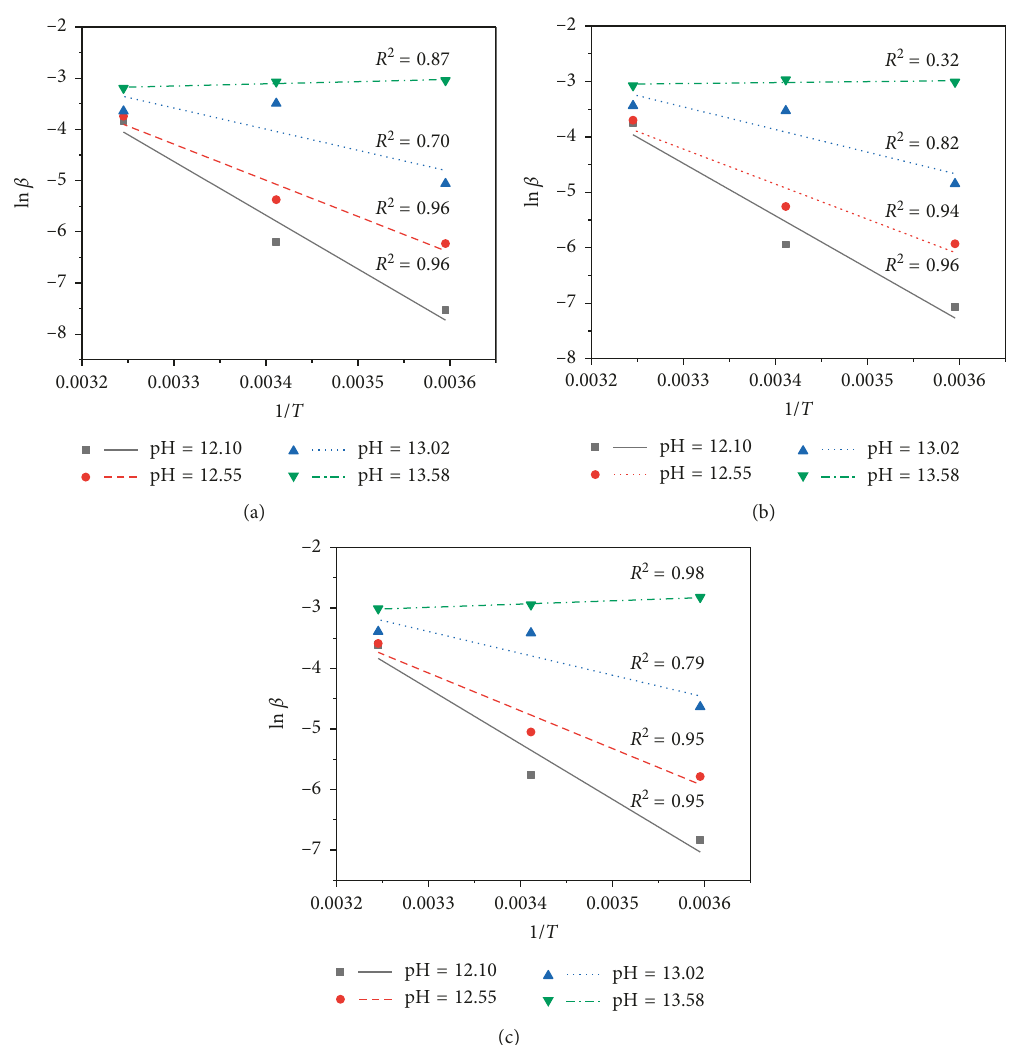
0.4; (b) w/s 0.5; (c) w/s (cid:31) (cid:31) (cid:31)